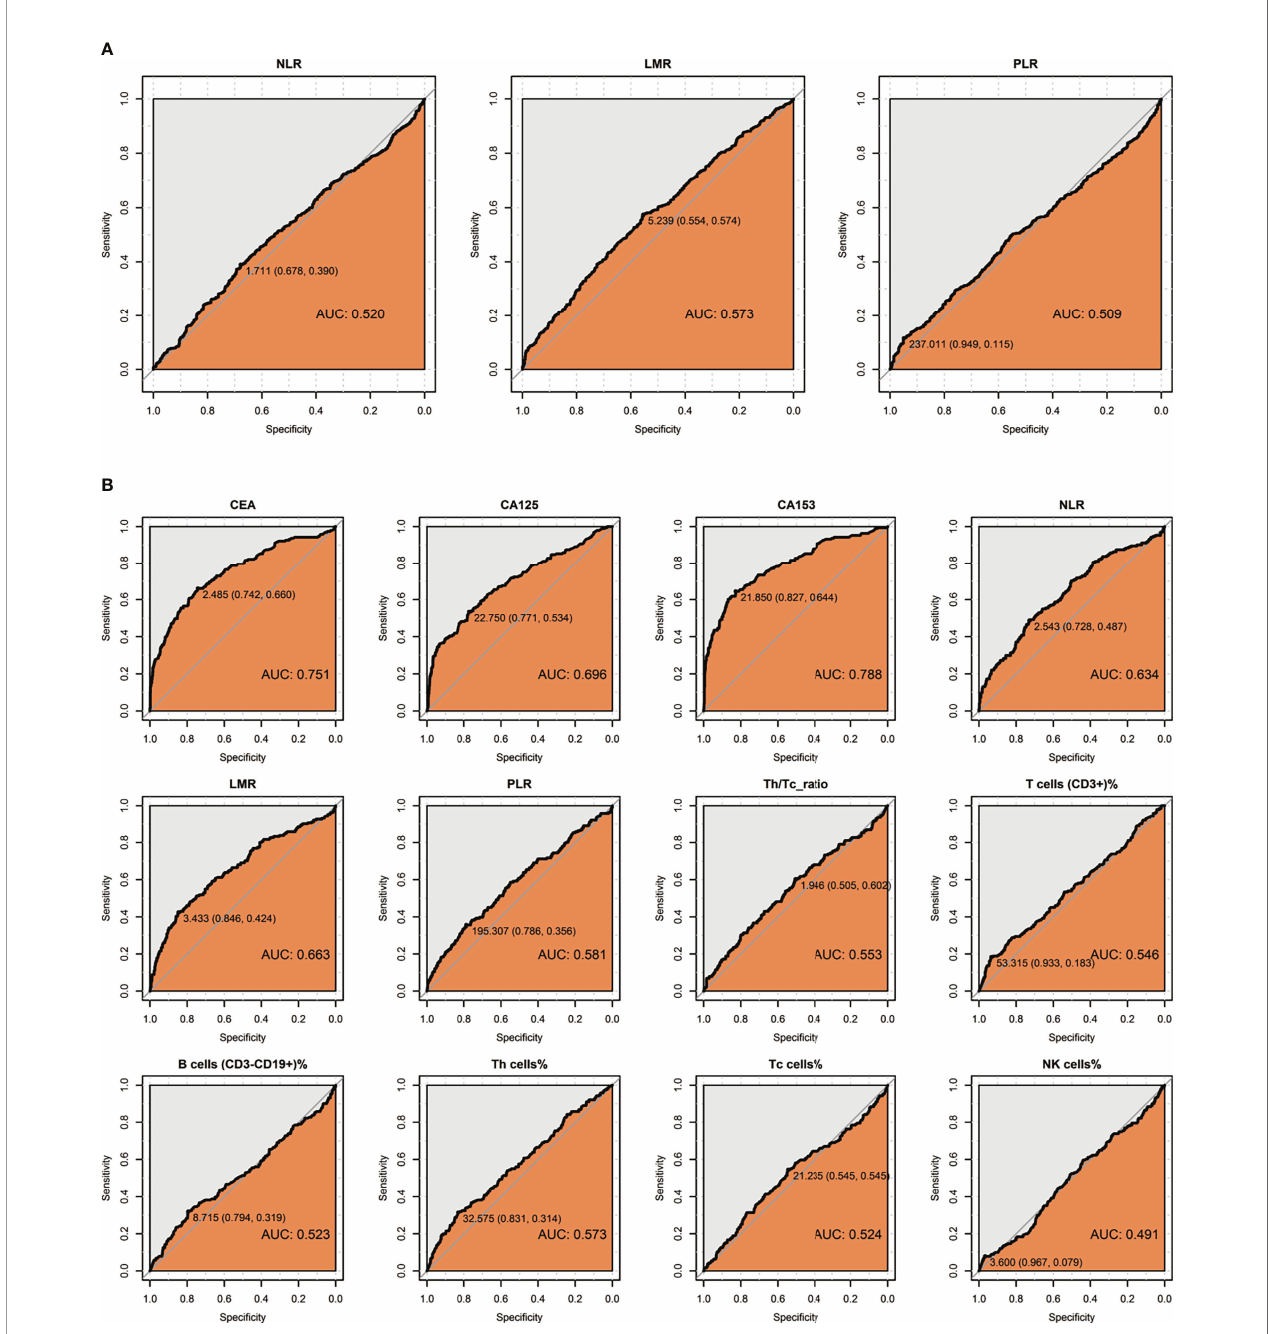
FIGURE 2 | ROC curve of peripheral blood indicators. (A) Perform ROC curve analysis on 1483 breast disease patients to select the best hematological index boundary value for distinguishing BC, including NLR, LMR, and PLR. (B) Performed on 938 BC patients to select the best cut-off value of hematological parameters for distinguishing patients with distant metastasis of BC, including CA153, CEA, CA125, NLR, LMR, PLR, Th cell%, Th/Tc radio, T cell%, Tc cell%, B cell%, NK